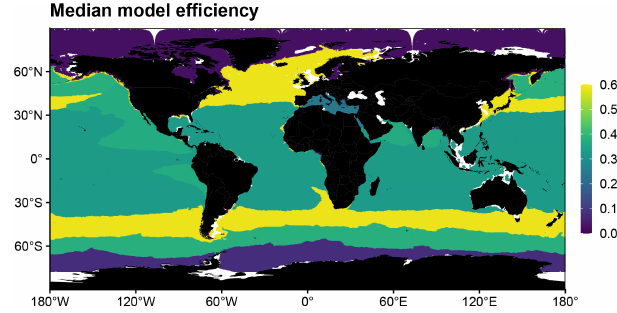
Figure 6. Median of the 23 m e values associated with each assess- ment metric by BGC